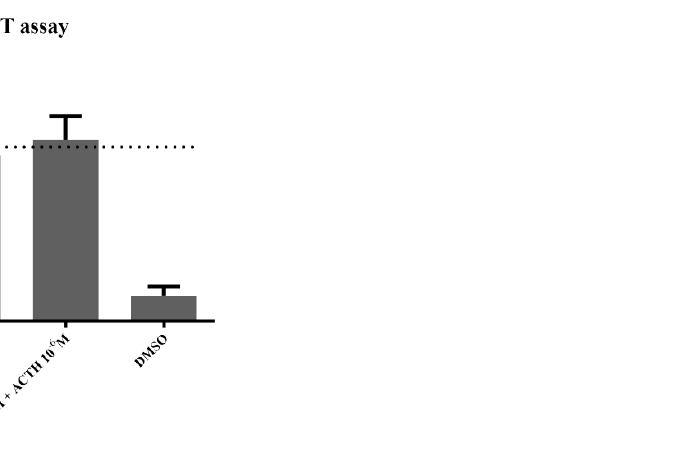
Figure 1. Tissue viability compared to control (expressed as %) after 1 h incubation with 10 − 6 M ACTH; 10 − 4 M metyrapone; simultaneous incubation with 10 − 6 M ACTH and 10 − 4 M metyrapone; DMSO. Results are expressed as average + SD.